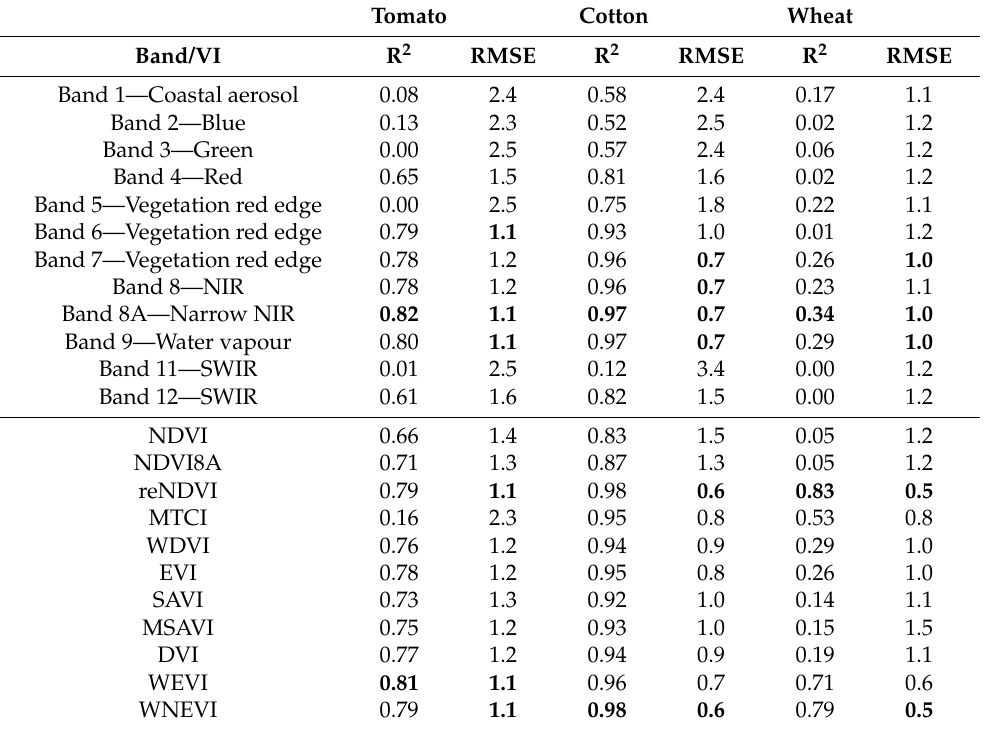
Table 3. Performance of Sentinel-2 bands and VIs used in the present study. The performance of best performing bands and VIs for each crop are in bold. Tomato Cotton Wheat Band/VI R